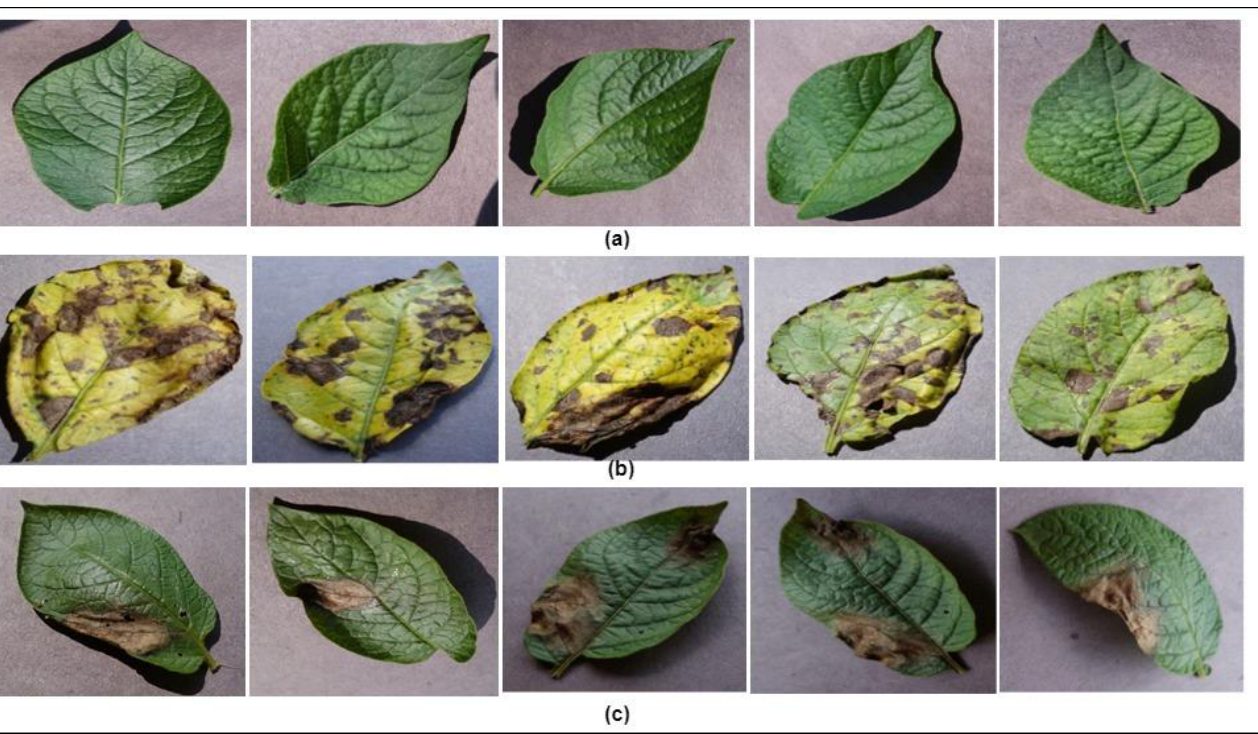
Fig. 1. Block diagram of the proposed method